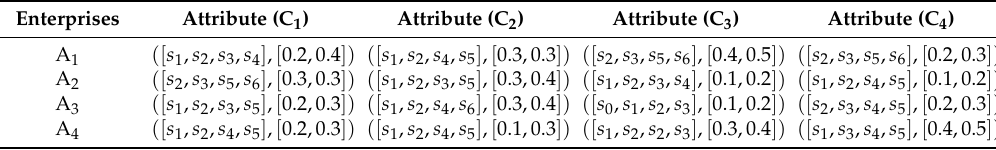
Table 3. The attribute values of each attribute with respect to four enterprises given by expert e 3